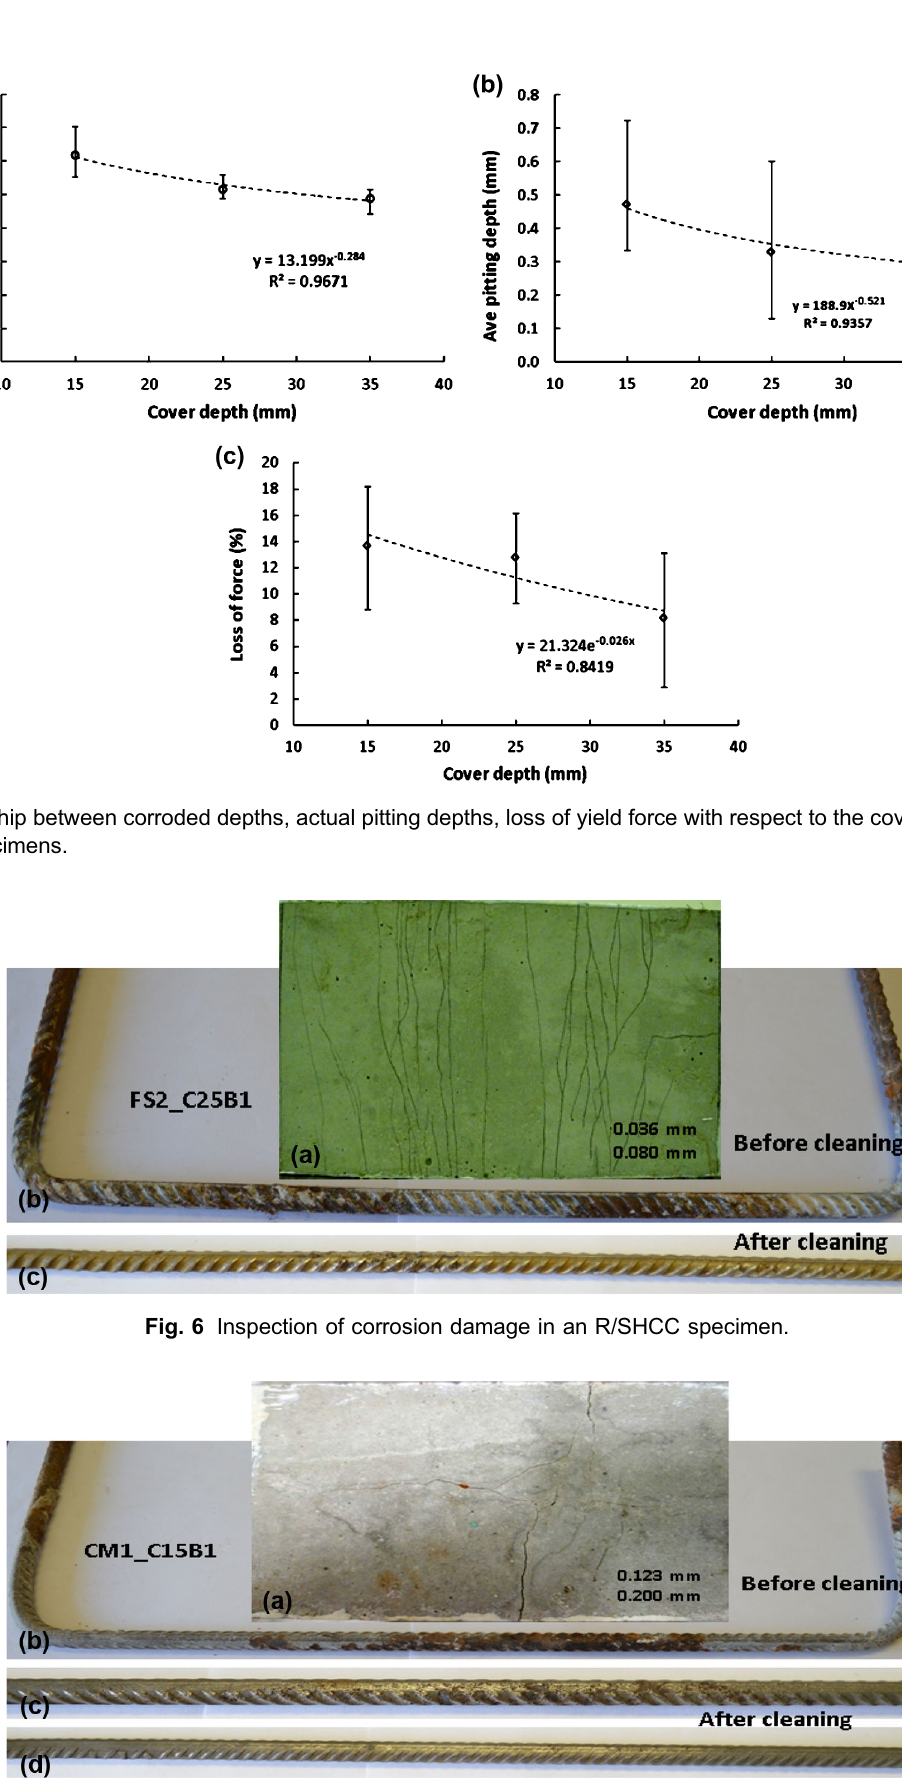
Fig. 7 Inspection of corrosion damage in an R/mortar